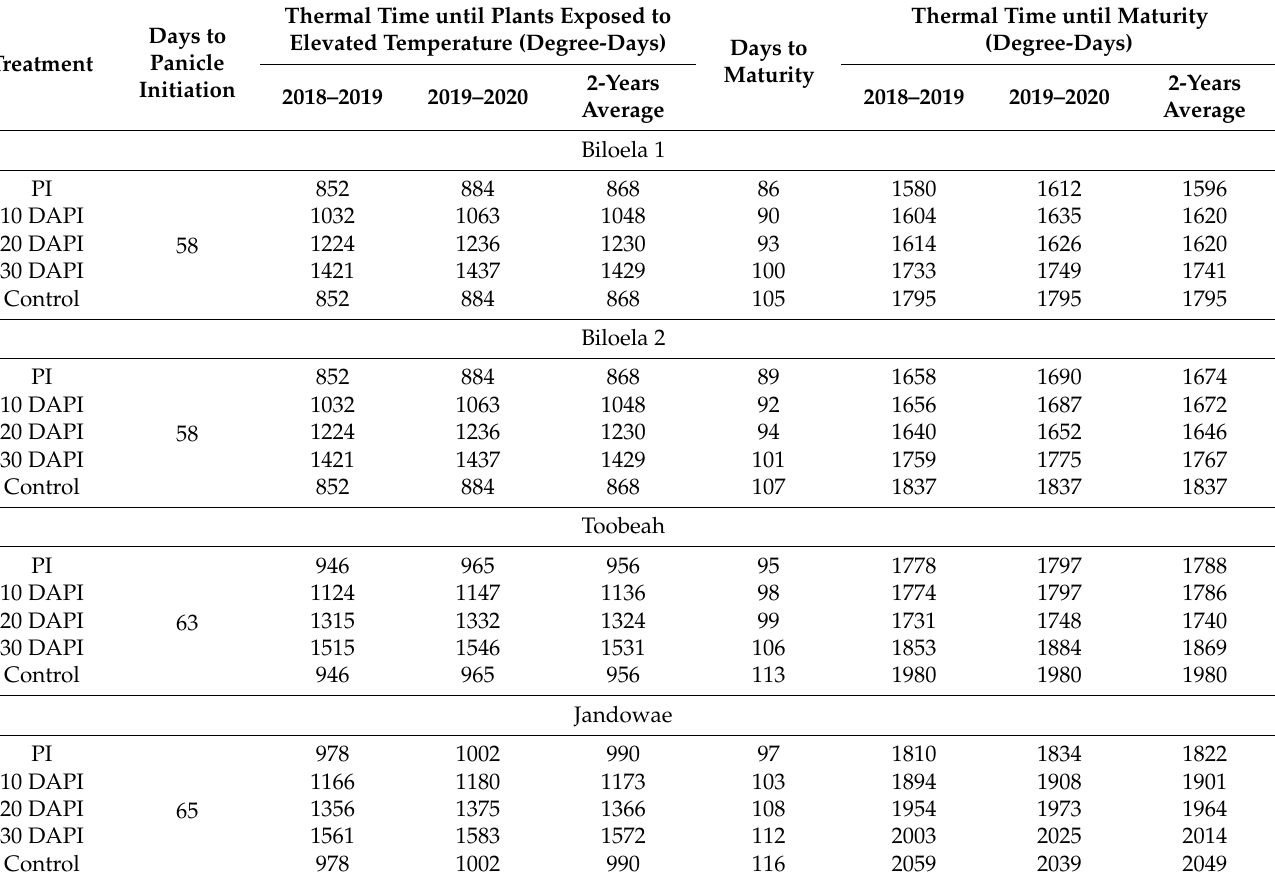
Table 4. Thermal time (degree-days) of four Avena sterilis ssp. ludoviciana biotypes. Plants were grown in an ambient greenhouse until panicle initiation. Plants were exposed to the elevated temperature